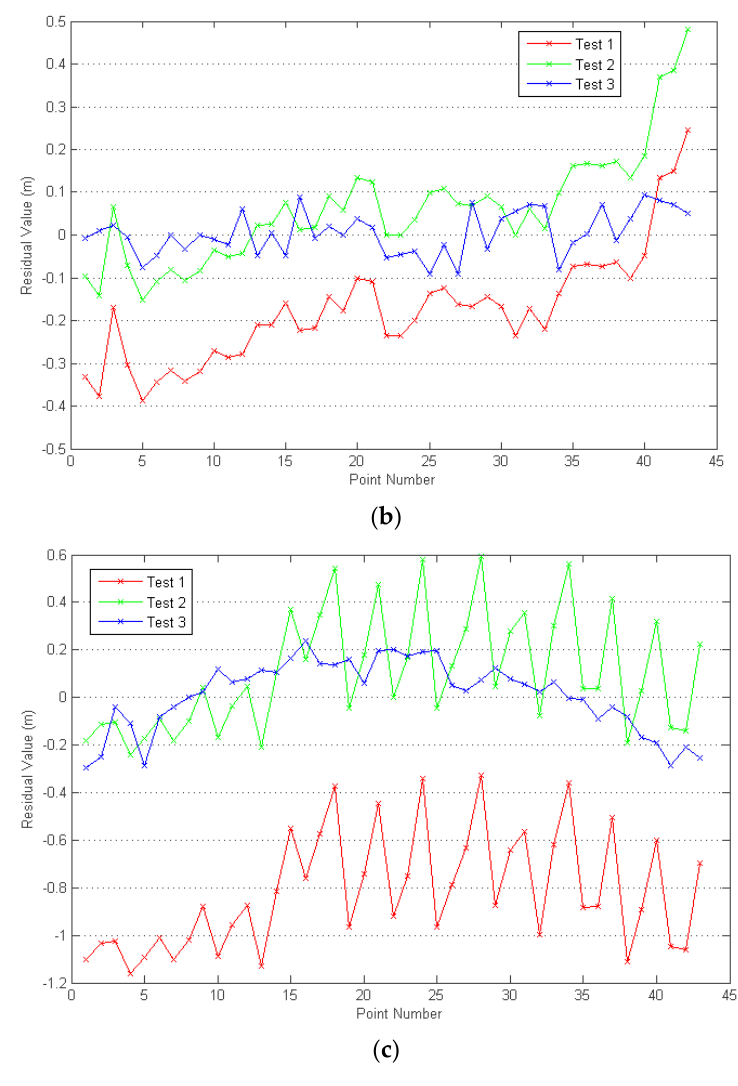
Figure 14. Orientation residuals for these three scenarios: ( a ) residual in X direction; ( b ) residual in Y direction; and ( c ) residual in Z direction.